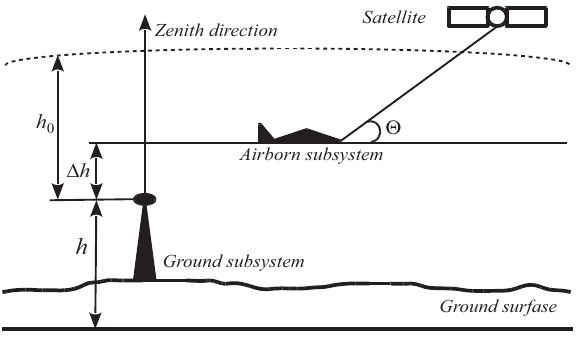
Figure 1. Schematic illustration of the parameters used for the tropospheric error